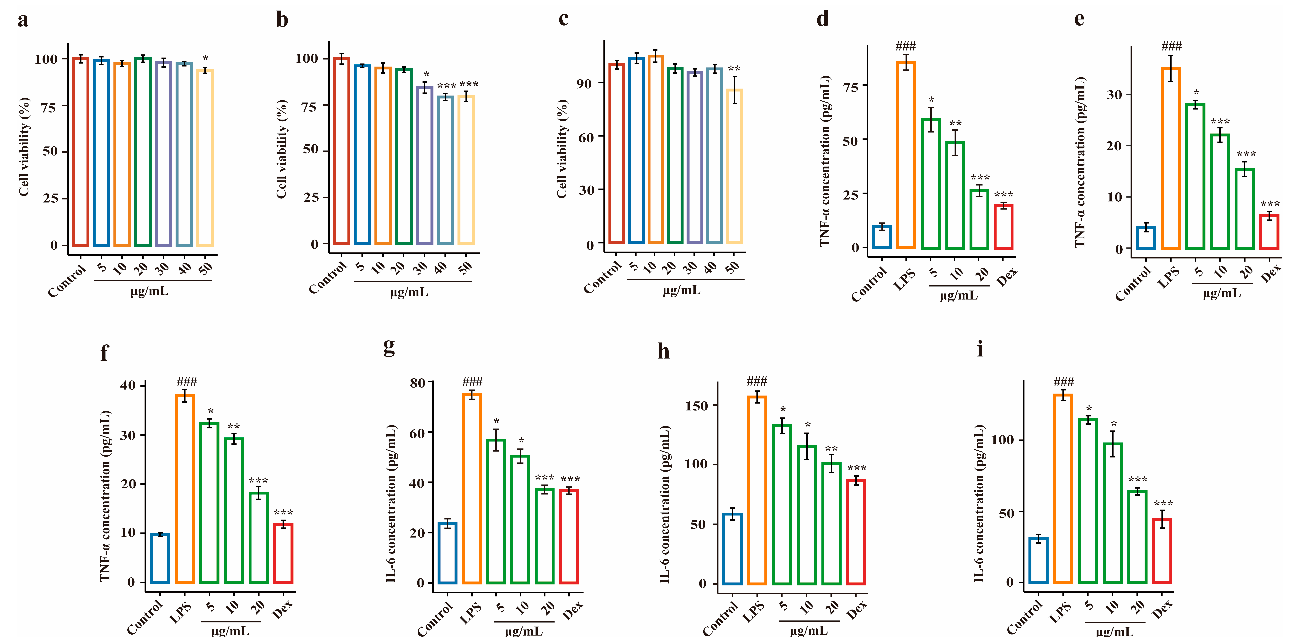
Figure 2. Effects of EDG on LPS-induced injury in target cells. ( a – c ) The cell viability of 16HBE, HPAEpiCs and HUVECs after treatment with different concentrations of EDG. ( d – f ) TNF- α production of 16HBE, HPAEpiCs and HUVECs, respectively. ( g – i ) IL-6 production of 16HBE, HPAEpiCs and HUVECs, respectively. The 16HBE, HPAEpiCs and HUVECs were pretreated with EDG at the concentration of 5–20 µ g/mL for 12 h. Cell viability was measured with the MTT assay, and Dex was used as a positive control drug (5 µ g/mL). TNF- α and IL-6 levels in the medium, as measured by ELISA. Results were obtained from three independent experiments and are presented as mean ± SEM. ### p < 0.001 vs. Control; * p < 0.05, ** p < 0.01, *** p < 0.001 vs. LPS. LPS, Lipopolysaccharide; Dex, Dexamethasone.